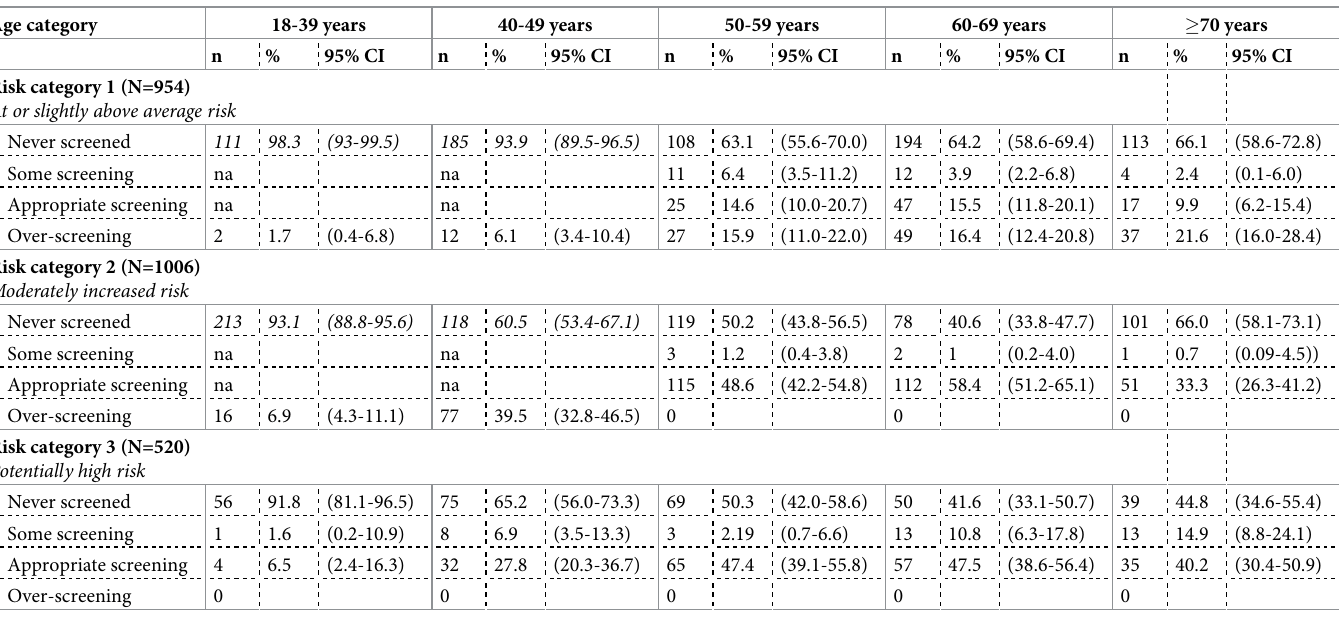
Table 2. CRC screening participation in the ACCFR by age and risk